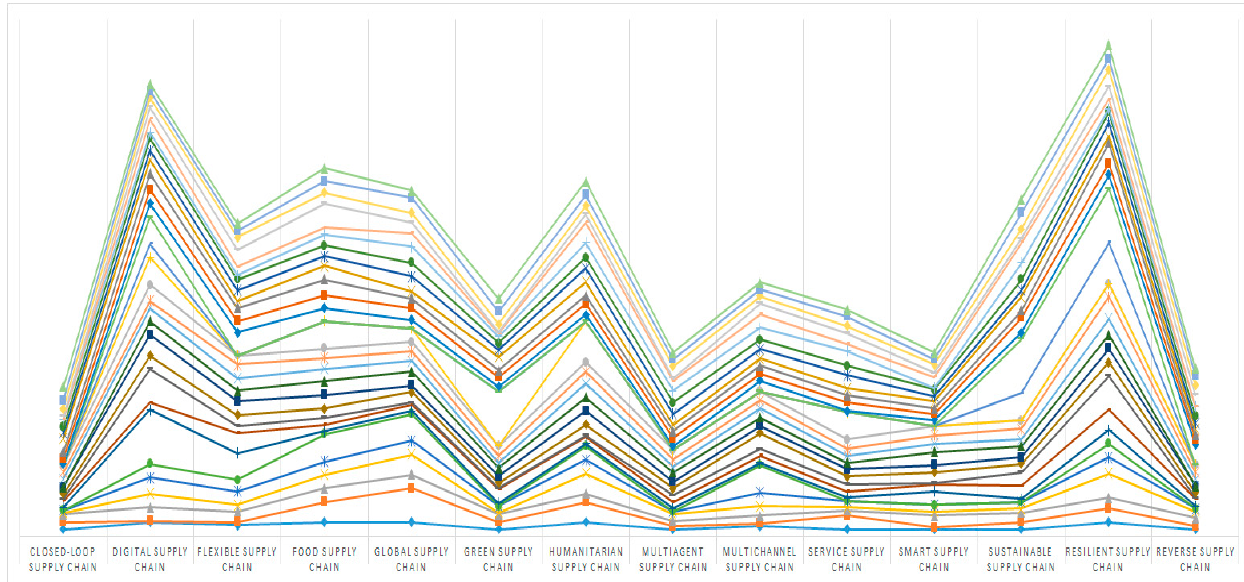
Figure 11. Ranking graph of global theoretical trends and supply chain development directions in the context of dynamic global changes related to the COVID-19 pandemic according to the experts’ assessments 1–30; own elaboration based on the conducted research. Table 4. Final results of opinions about global theoretical trends and supply chain development directions in the context of dynamic global changes related to the COVID-19 pandemic, according to the experts’ assessments 1–30; own elaboration based on the conducted